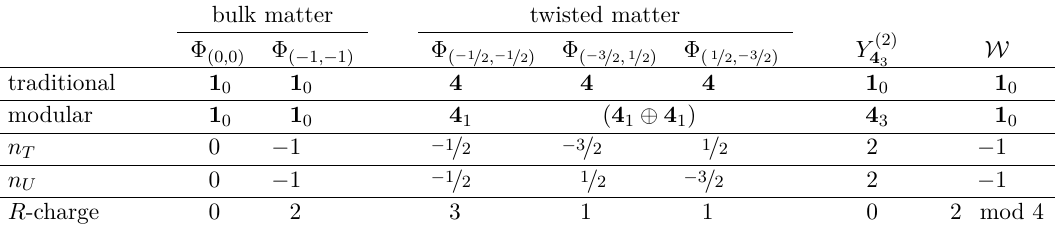
as well as their rep- ( n T ,n U ) of a T 2 / Z orbifold sector, see appendix D. The 2 4 . The traditional flavor ( n T ,n U )